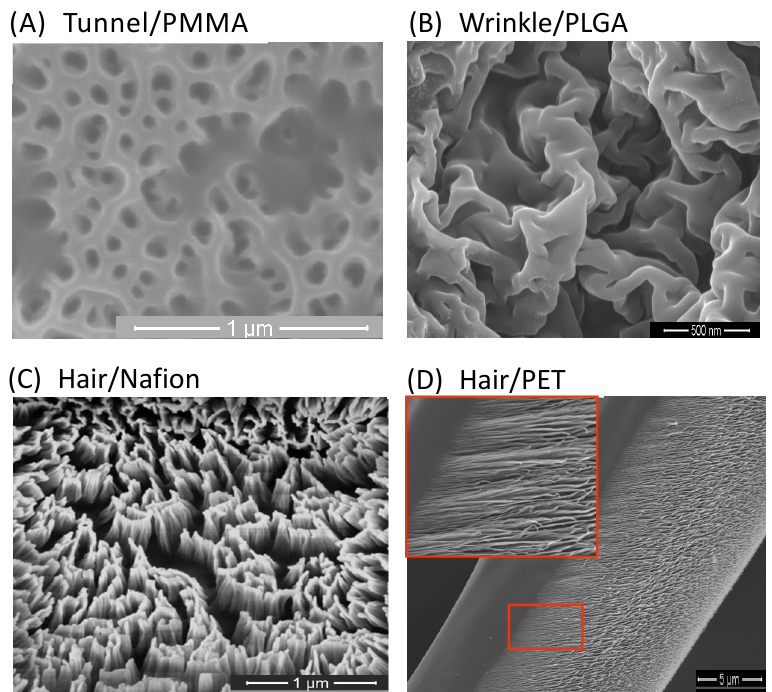
Figure 1. SEM images for nanostructured polymers by plasma ions ( A ) tunnel-like pores on PMMA surface; ( B ) surfaces wrinkles on PLGA; and ( C , D ) nanohairs on Nafion and PET with different ion beam directions to the surface: perpendicular and tilted angle, respectively.